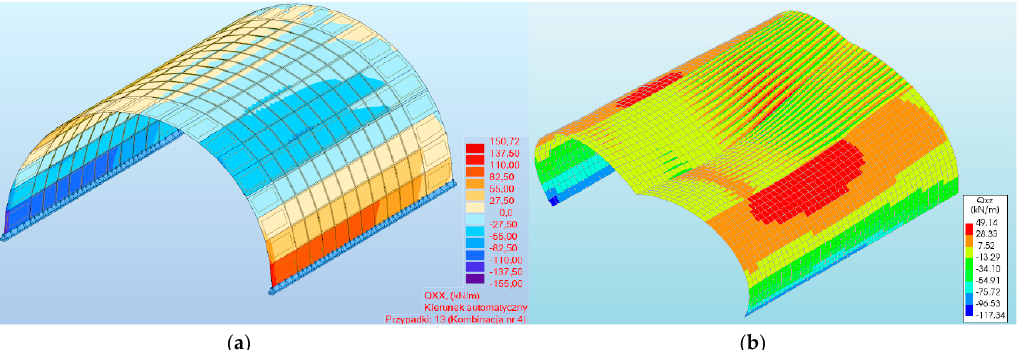
Figure 9. Maximum shearing forces of a three-hinged arch viaduct obtained in the program: ( a ) #1, ( b ) #2.